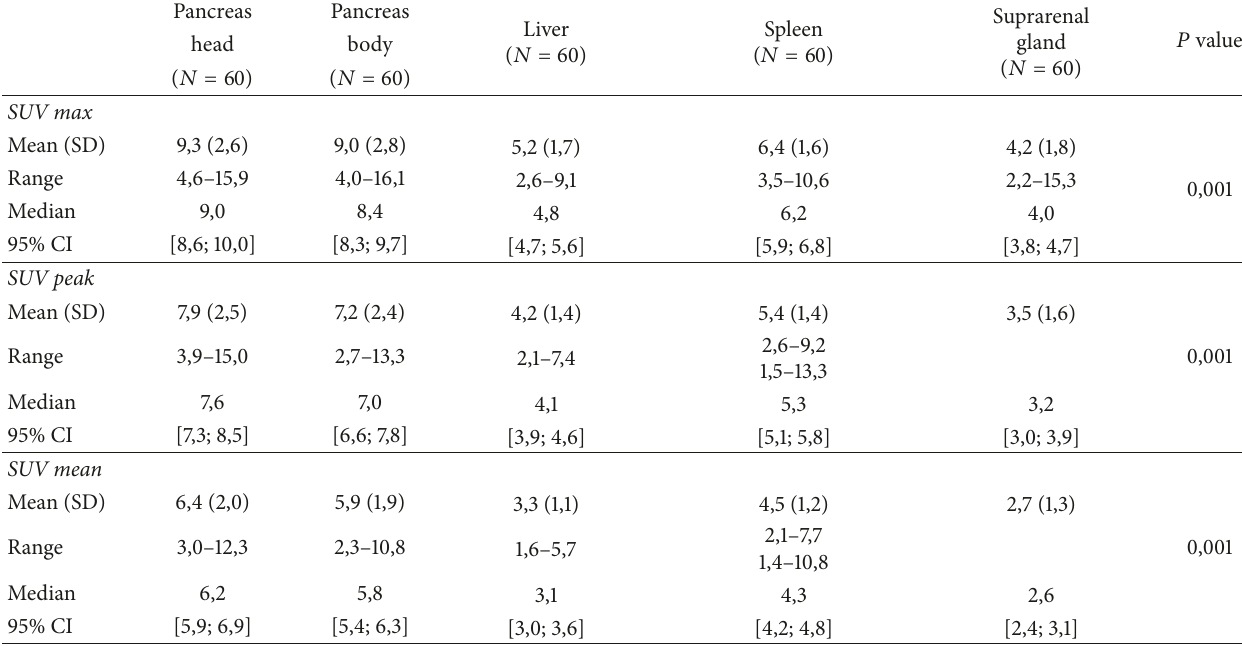
Table 2: Comparison of 11 C-acetate uptake by